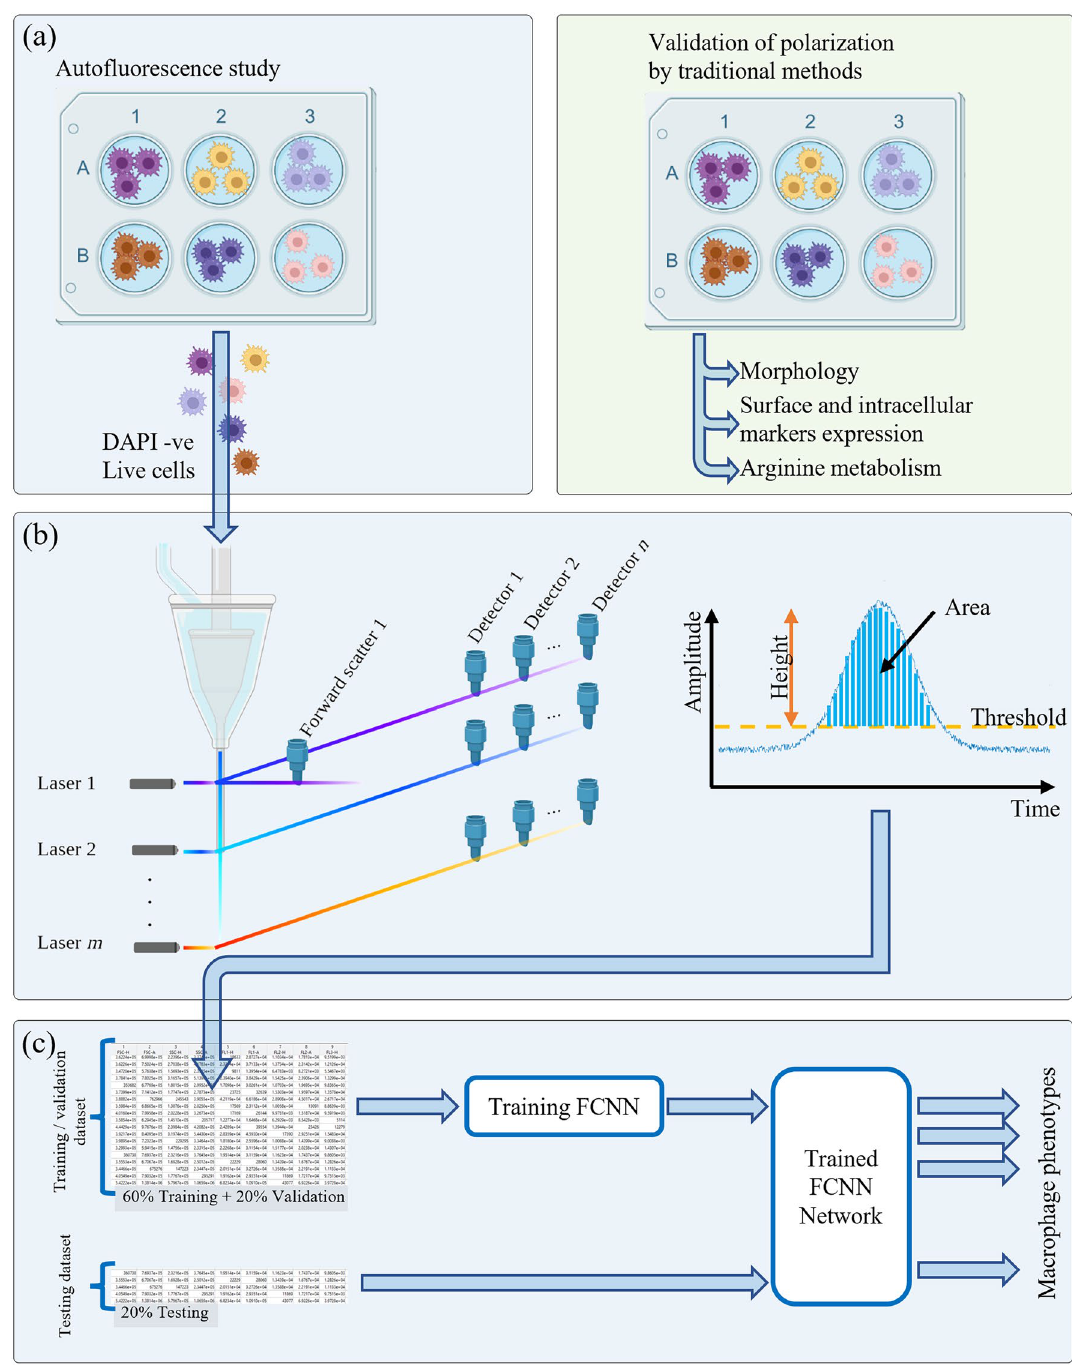
Figure 1. Workflow of the macrophage intrinsic signal analysis. ( a ) Right block: six macrophage phenotypes were induced by applying different stimuli and macrophage polarization confirmed by measuring biological characteristics validated in accordance with previous studies. ( a ) Left block: a separate macrophage polarization experiment was used to investigate the autofluorescence signature for each phenotype. DAPI staining was used to exclude dead cells and autofluorescence of live cells was measured. ( b ) Label free polarized (DAPI-/ live) macrophage samples were acquired in a Beckman Coulter CytoFLEX LX flow cytometer recording 45 parameters per cell = 20 fluorescence detector × 2 (height and area) + forward scatter 1 × 3 (height, area, width) + side scatter 1 × 2 (height and area). ( c ) The generated data was divided into three parts: training (60%), validation (20%), and testing (20%), where a supervised fully connected neural network (FCNN) classified the different phenotypes based on cell specific